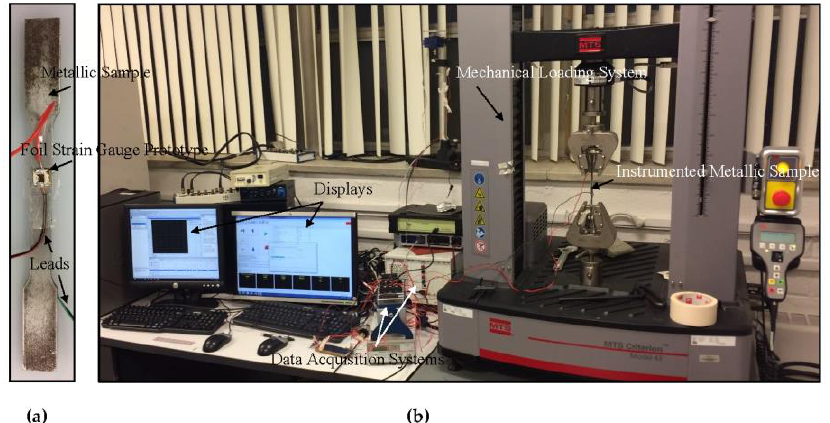
Figure 7. ( a ) Optical image of the dog-bone steel sample instrumented with a foil strain gauge prototype; ( b ) Experimental setup used to calibrate foil strain gauge prototypes.